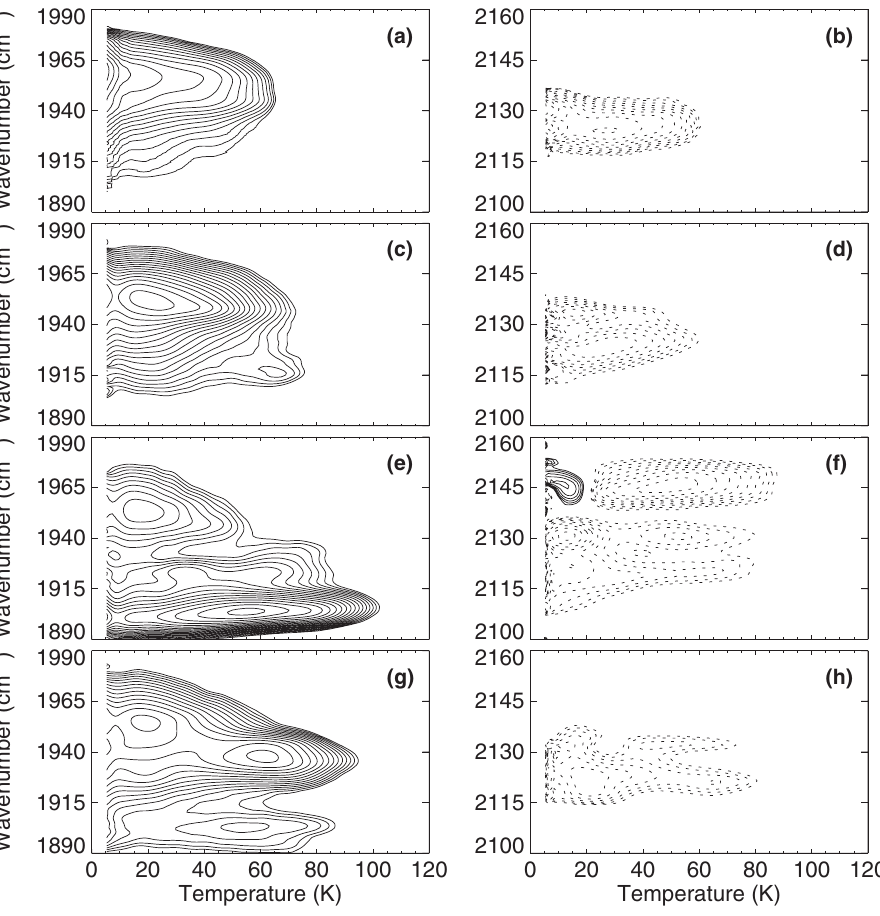
Figure 3. TDS contour maps of iNOS -CO, obtained after 10-s illumination at 4 K. Left column: Absorption changes in the bands of oxy heme-bound CO. Right column: Absorption changes in the photoproduct bands. Contours are spaced logarithmically; solid and dotted lines represent increasing and decreasing absorption, respectively. iNOS -CO ( a , b ) w/o substrate; ( c , d ) with H4B; ( e , f ) with L-Arg; ( g , h ) with oxy NOHA. A bands and the photoproduct bands in the left and right columns,